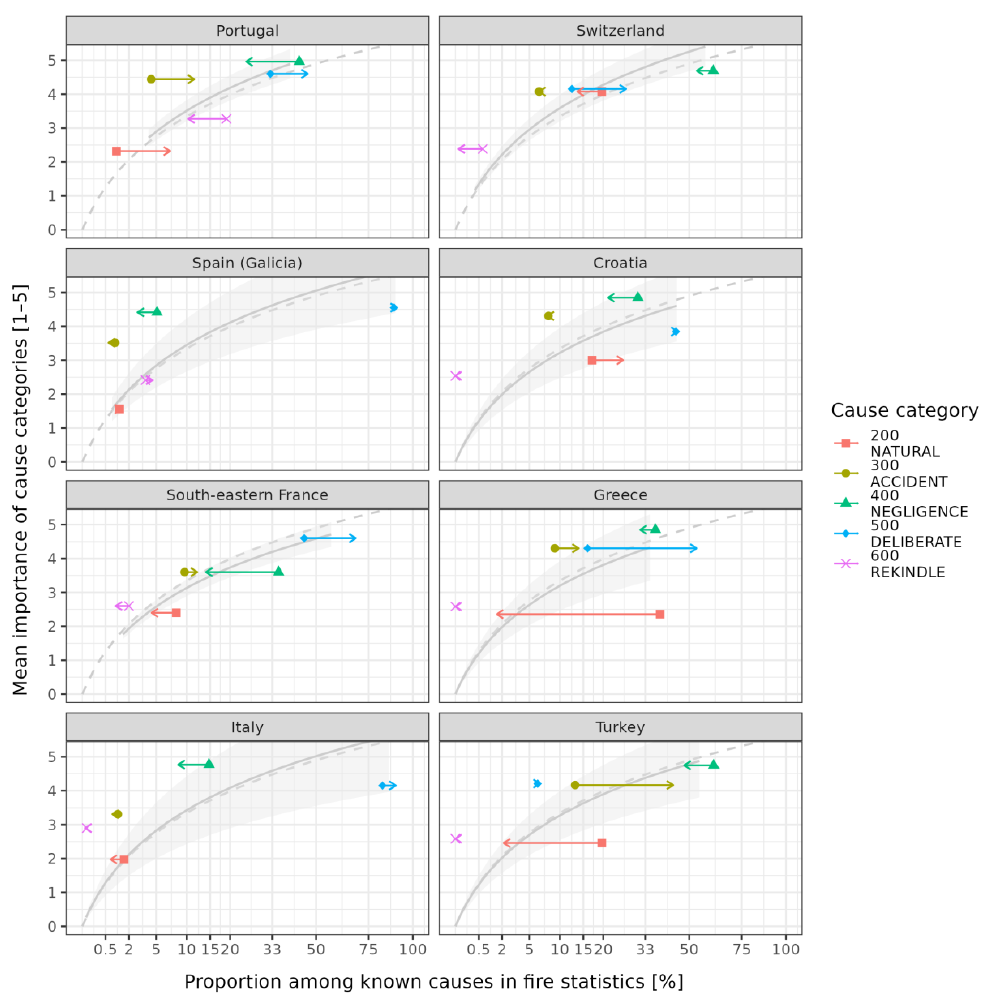
Figure 4. Mean expert rating and fire statistics (Dataset B) of known causes. Segments span the difference in the percentages represented by fire frequency (symbols of the regions) and burnt area (arrowheads). Solid grey lines represent a logarithmic fitting of the data (average values were used for fire statistics) with the 68% confidence interval. The dashed line represents the reference fit across all countries (see Figure S1 in the Supplementary Materials). The X axis is plotted on a square root-transformed